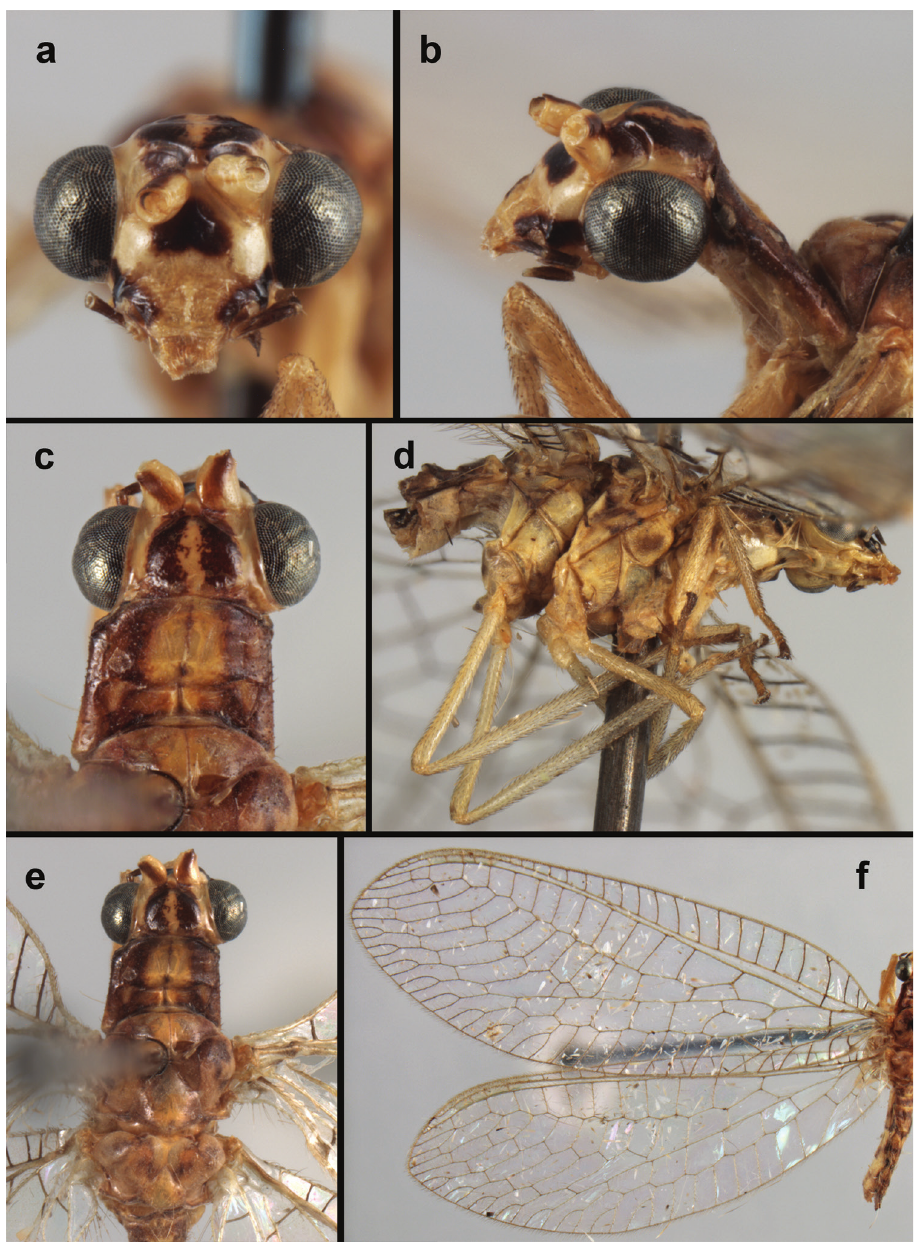
Figure 77. Ungla quchapampa Tauber, sp. n. External features, ( a ) head, frontal ( b ) head, prothorax, lateral ( c ) head, prothorax, dorsal ( d ) thorax, lateral ( e ) head, thorax, dorsal ( f ) left wings (Bolivia, Cocha- bamba, holotype, male,